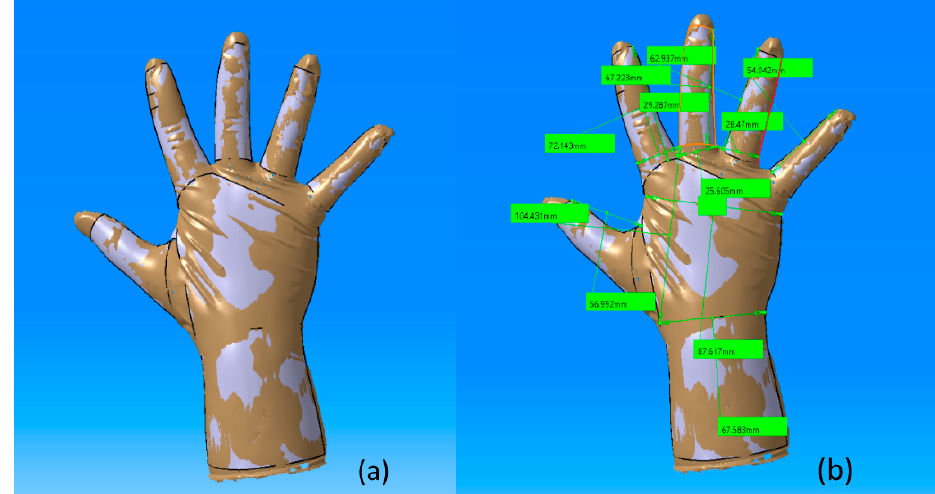
Figure 3. Solid model of the 3D-scanned hand. ( a ) Solid Model, ( b ) Solid Model with Dimensions.